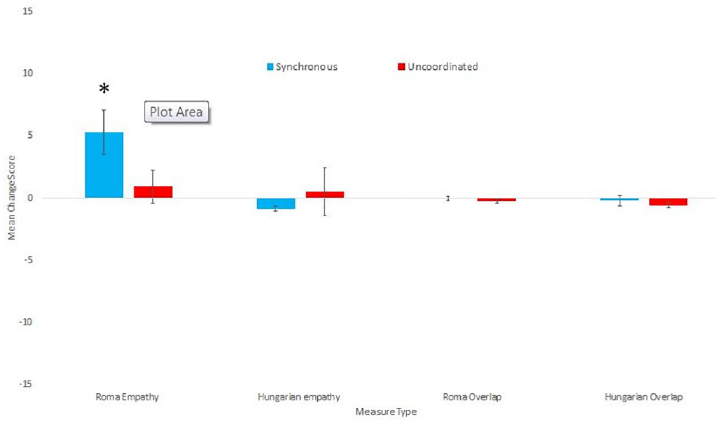
Fig 6. Means and standard errors for Empathy and Overlap change scores towards each group type in Study